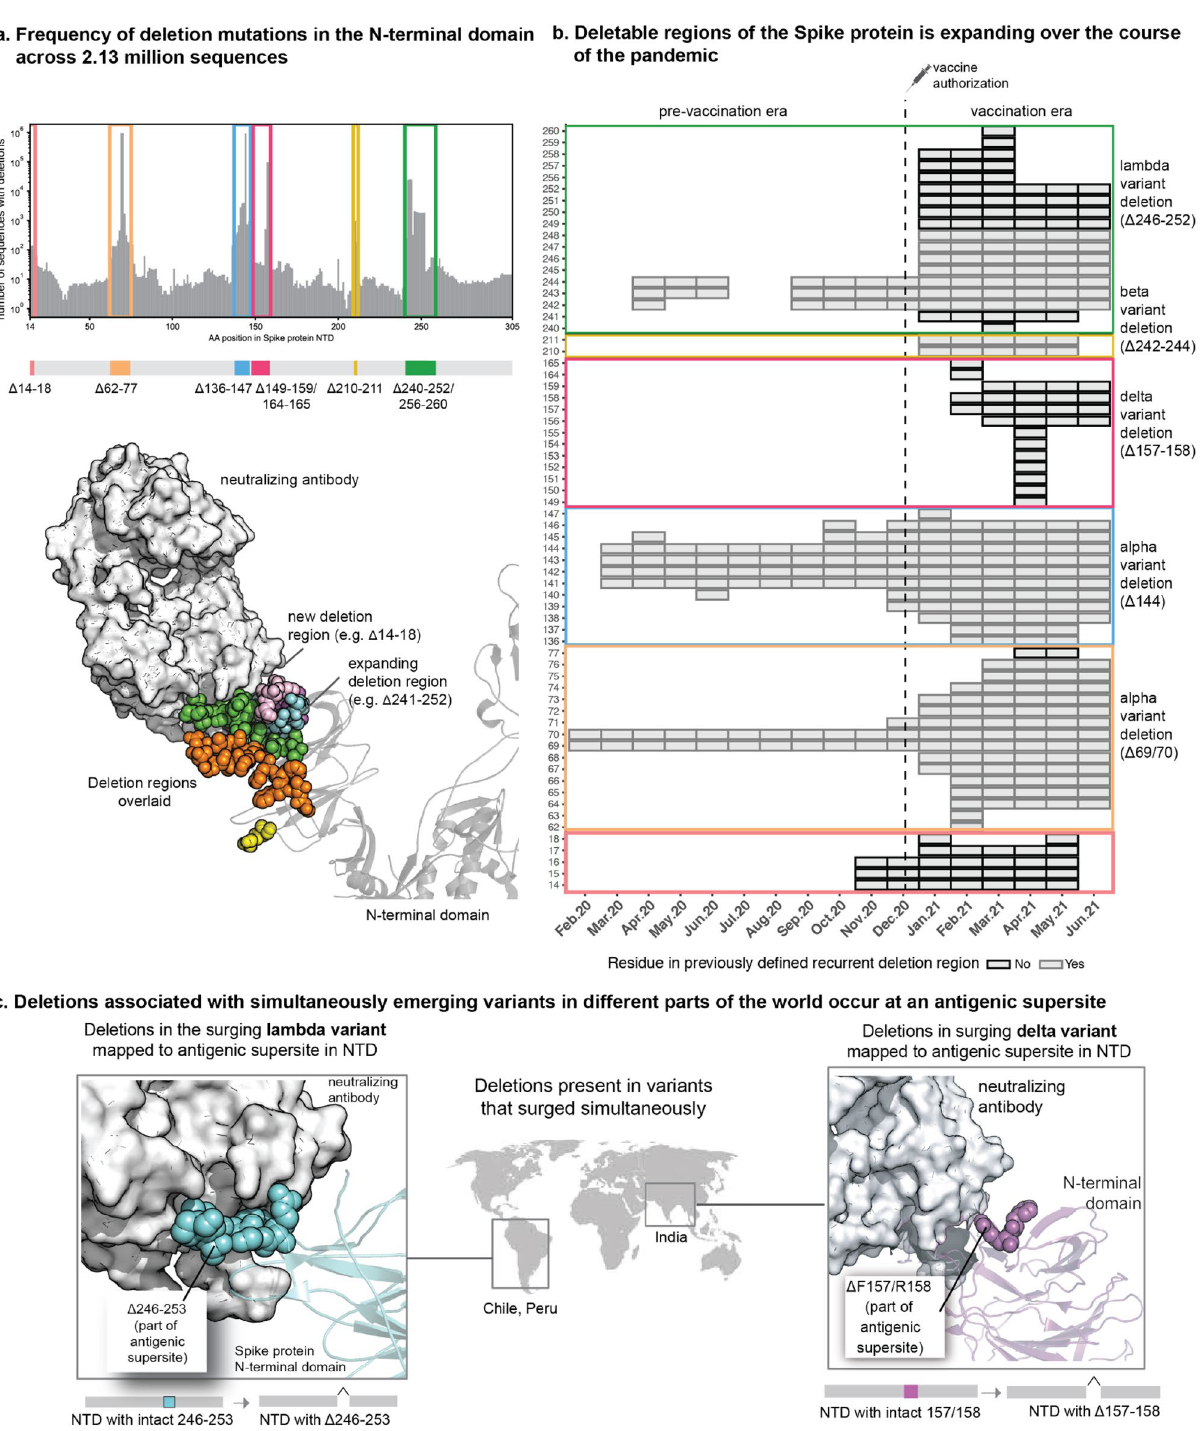
Figure 2. The repertoire of deletions in the Spike protein N-terminal domain is expanding over the course of the pandemic. ( a ) Frequency of occurrences of deletion mutations in the N-terminal domain across 2.13 million Spike protein sequences (as of 30 June 2021). The recurrent deletion regions, both known and new, are illustrated schematically and mapped on the structure of the Spike protein. Positions corresponding to the deletion mutations in the Spike protein are shown as colored spheres, and the neutralizing antibody is shown using a surface representation in grey. ( b ) Heatmap showing the expansion of “deletable” regions in the course of the pandemic, where the rows denote residue positions in the Spike protein and columns denote the time course of the pandemic (in months). Each box denotes the frequency of a given deletion mutation across the world in that month. The color of the boxes corresponds to a frequency of 1 to 100,000 sequences shown on a log10 scale. ( c ) Sites of deletion mutations associated with surges in different parts of the world are shown as spheres on the 3D structure of the Spike protein complexed with neutralizing antibody 4A8 (PDB identifier: 7C2L described by Chi et al. 18 , retrieved from the